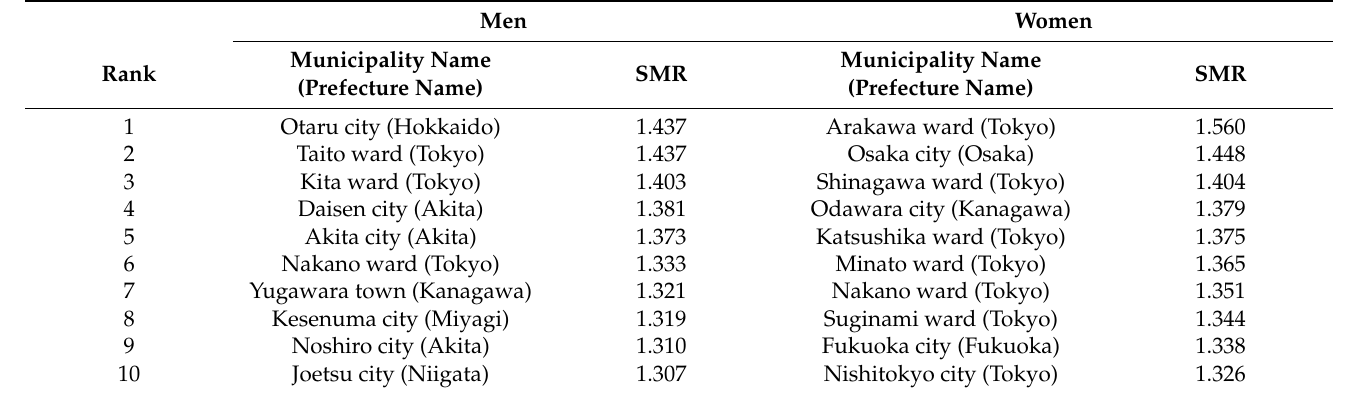
Table 1. Top 10 municipalities with high SMR of esophageal cancer.